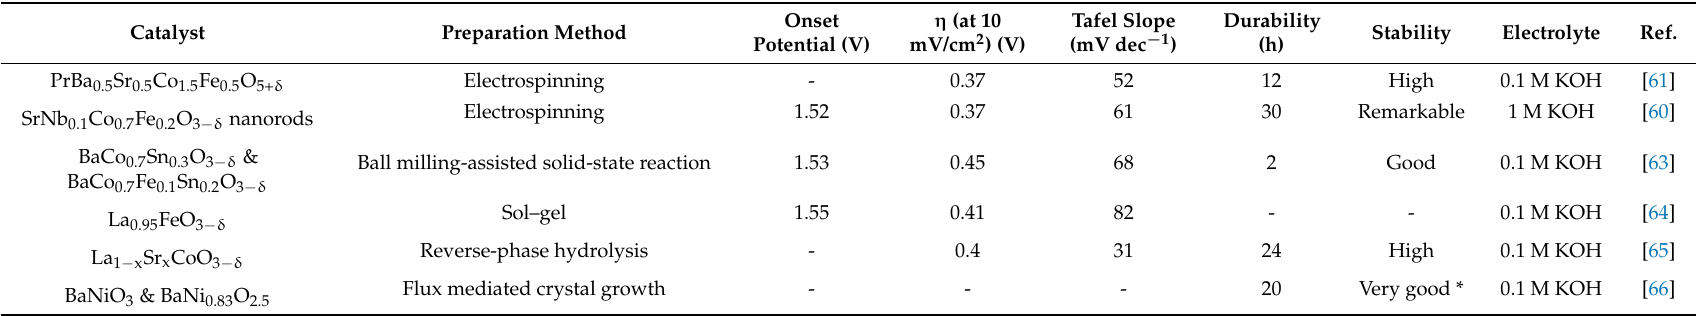
Table 4. Comparison of the electrocatalytic activity of perovskite oxide catalysts (cf. Table 1 for definitions of “durability” and “stability”).